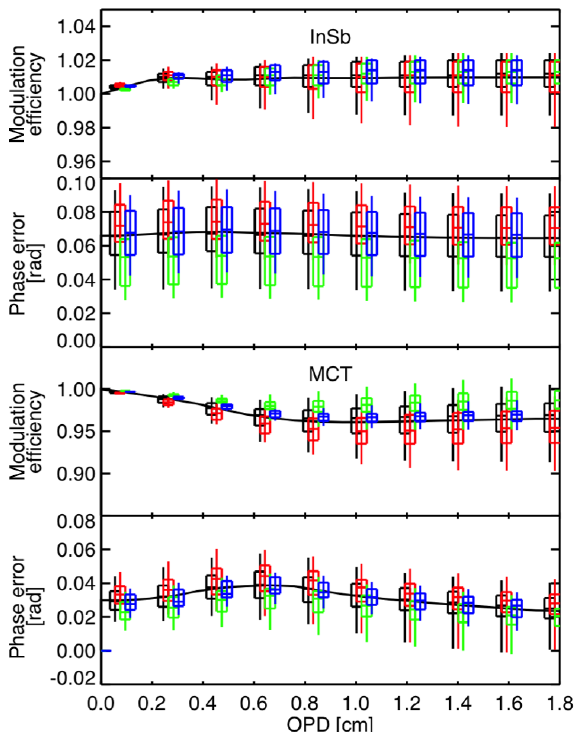
Figure 5. Instrument line shape (ILS) modulation efficiency and phase error as a function of optical path difference (OPD). Top pan- els: InSb detector. Bottom panels: MCT detector. Boxes mark 25th and 75th percentiles, and the line inside the box marks the median. Lines outside the boxes indicate 5th and 95th percentile. Green, red and blue represent averages over an elevation angle of 5, 45 and 65 ◦ , respectively. Black is the average over all data. The different colored whiskers are offset with respect to the OPD for visualiza- tion; green whiskers are located at the exact